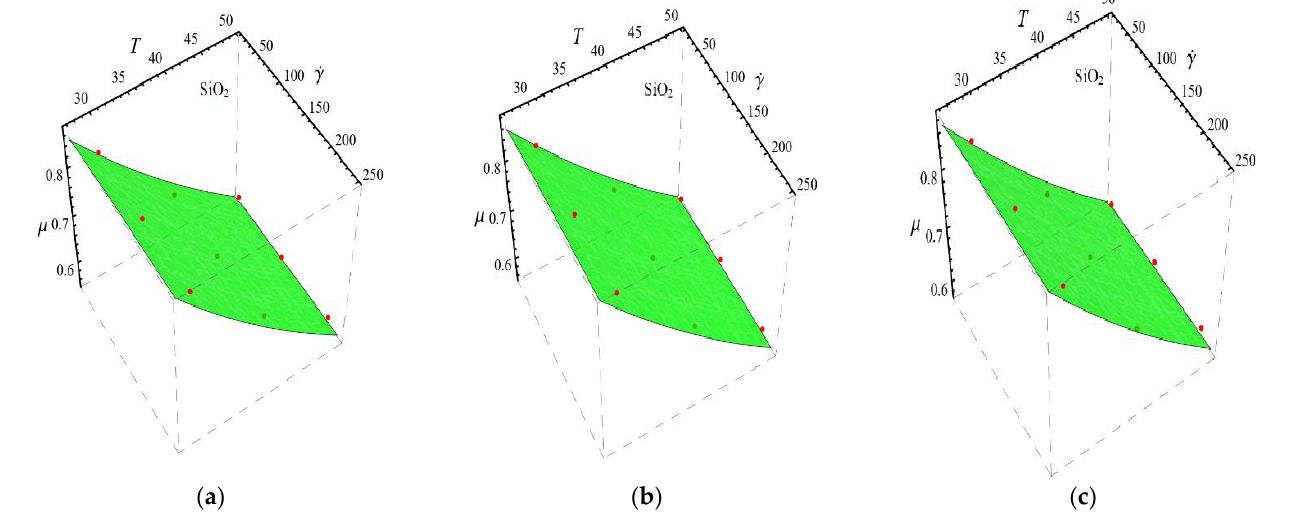
Figure 1. Fitting the Equation (2) for experimental data of SiO 2 /DIW nanofluid at different nanopar- ticle volume fractions ( a ) φ = 0.025%, ( b ) φ = 0.05% and ( c ) φ =